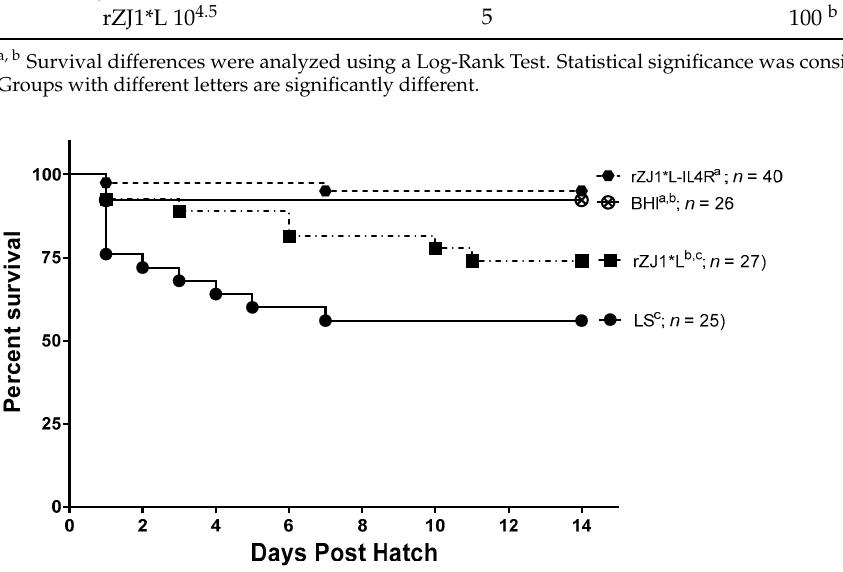
Figure 5. Effect of rZJ1*L-IL4R vaccination at 19 DOE on survival. At 19 DOE, SPF embryonated chicken eggs ( n = 25–40) were vaccinated in ovo with 10 3.5 EID 50 of rZJ1*L-IL4R, rZJ1*L, LS or with brain heart infusion (BHI) control. Post-hatch, chickens were housed in negative pressure isolators and their survival was checked daily for 14 days. Survival curves were analyzed using the Log-rank test ( p ≤ 0.05). Groups with different letters are significantly different.